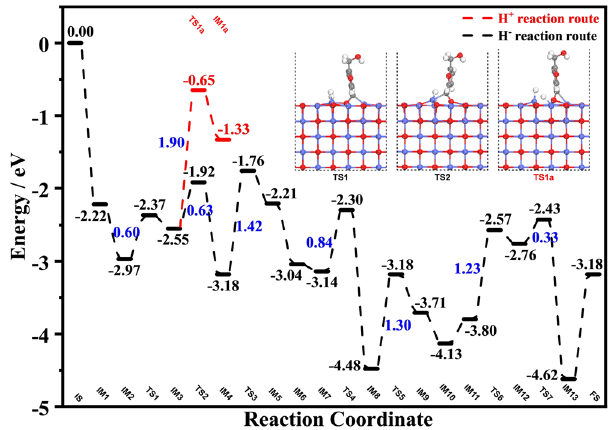
Fig. 6 Calculated energy pro fi les of HMF hydrogenolysis reaction on the CoO(100)-O V surface. Red dotted line refers to the H + route, black dotted line is the H − route. The corresponding energy barriers (E a , blue) for key steps are also included (in eV). The details in each separate step is provided in Supplementary Fig.